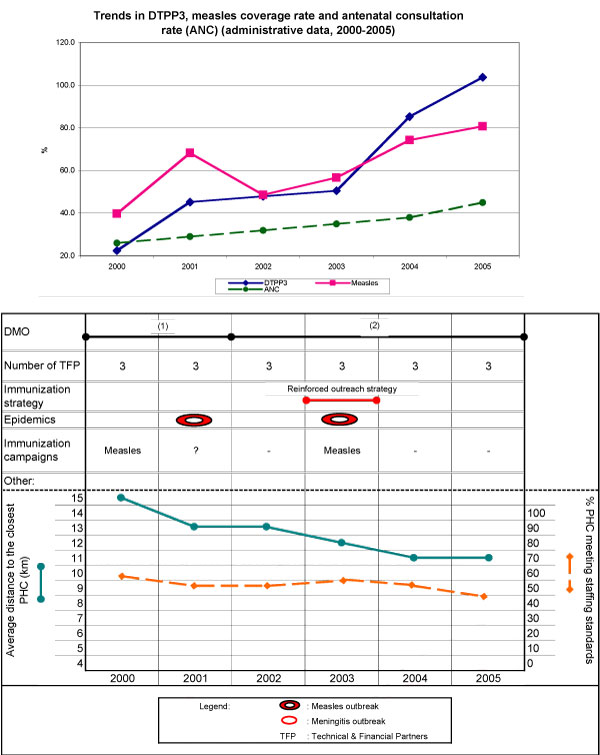
Health district of Dara.